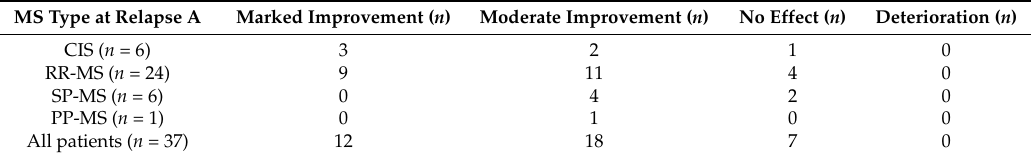
Table 3. Clinical response to TPE for relapse A in patients with CIS and MS.